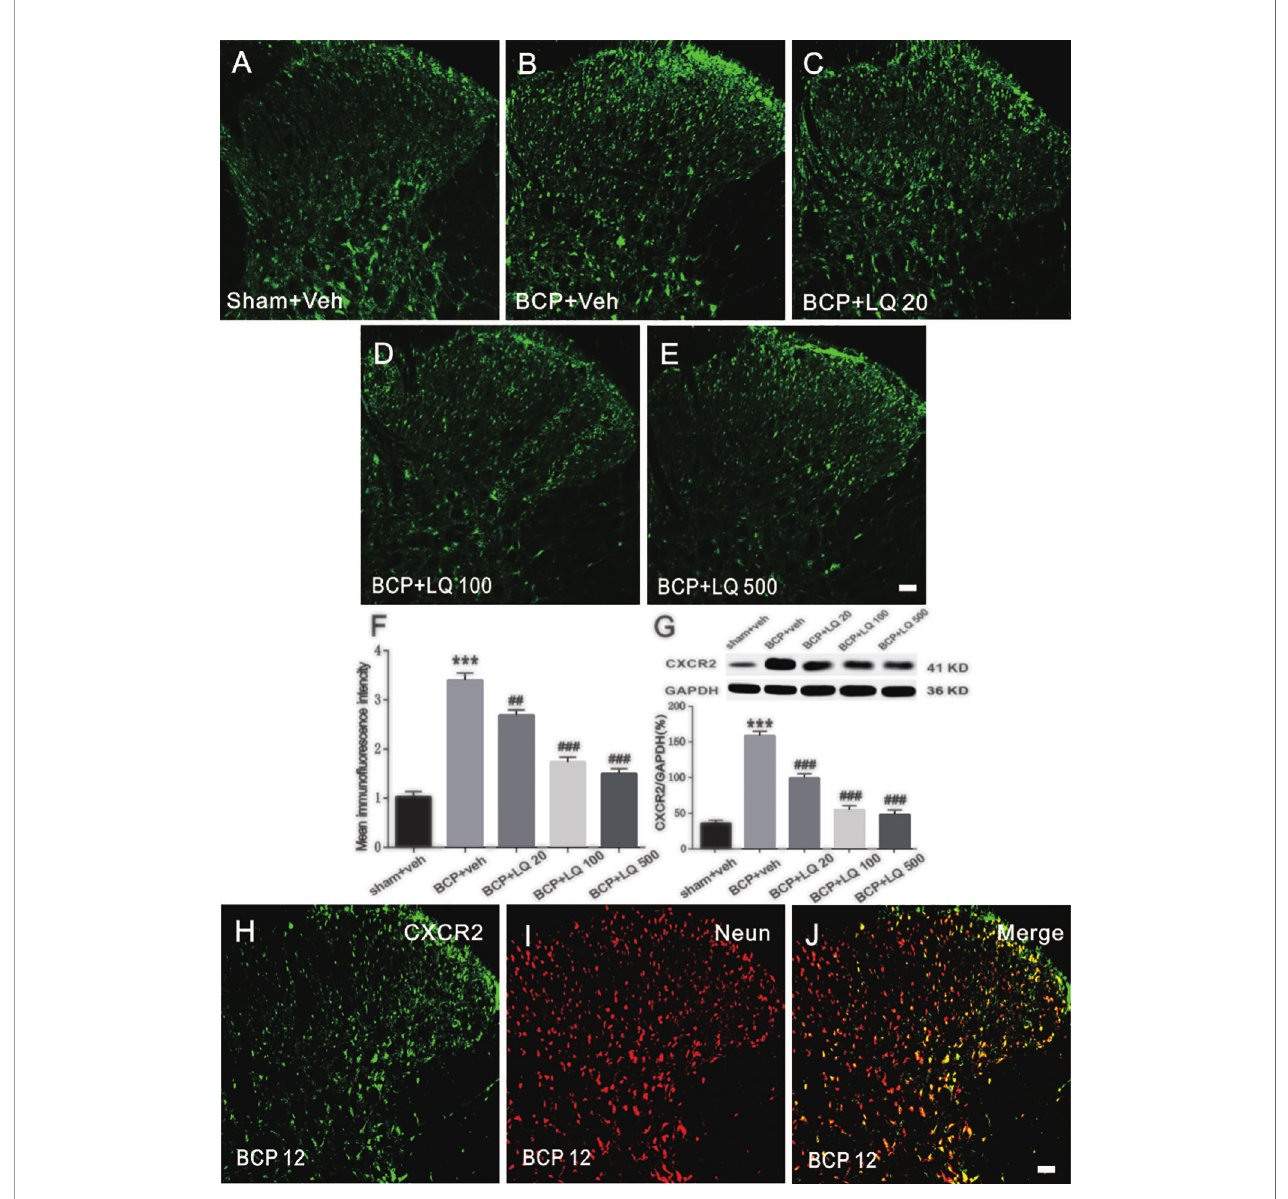
FIGURE 6 | Effects of intrathecal injection of Liquiritin (LQ) on bone cancer pain (BCP)-induced CXCR2 upregulation in the spinal neurons. (A – E) BCP induced a remarkable upregulation of CXCR2 in the ipsilateral spinal dorsal horn. Intrathecal LQ administration inhibited BCP-induced increase in CXCR2 immunoreactivity in the spinal cord. Scale bar 100 m m; mean immuno fl uorescence intensity (F) and western blot (G) of CXCR2 expressions after different treatments (F 4,15 = 66.22, ***P < 0.001 vs. sham + Veh group; ## P < 0.01, ### P < 0.001, vs. BCP + Veh group; F 4,15 = 72.94, ***P < 0.001 vs. sham + Veh group; ### P < 0.001 vs. BCP + Veh group; n = 4, one way ANOVA, 6F, G ). (H – J) Immunostaining images demonstrated CXCR2 (green) was predominantly co-localized with NeuN (red) as shown by overlapped staining (the rightmost panel, yellow). Scale bar, 100 m